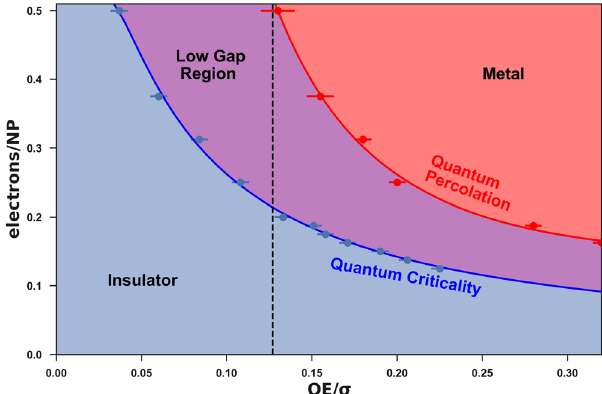
Figure 5. Phase diagram on the electron density vs. ( OE / σ )